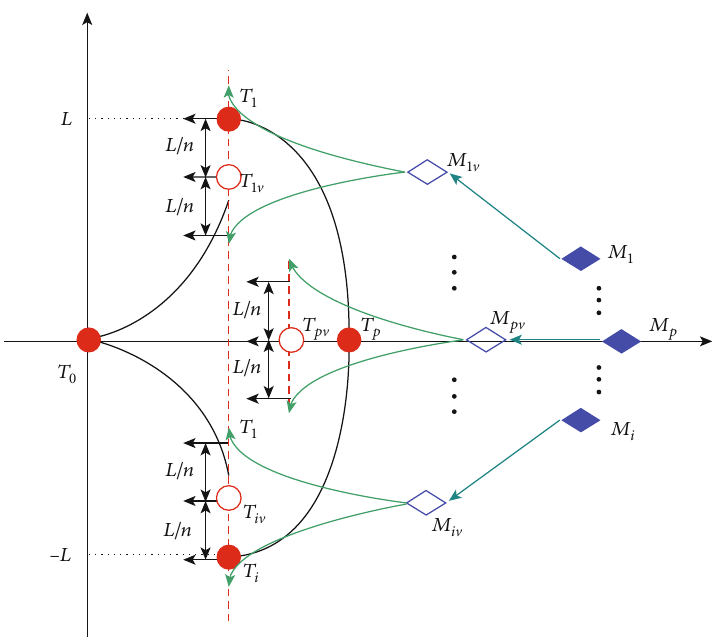
Figure 3: Guidance geometry on Missiles-Targets